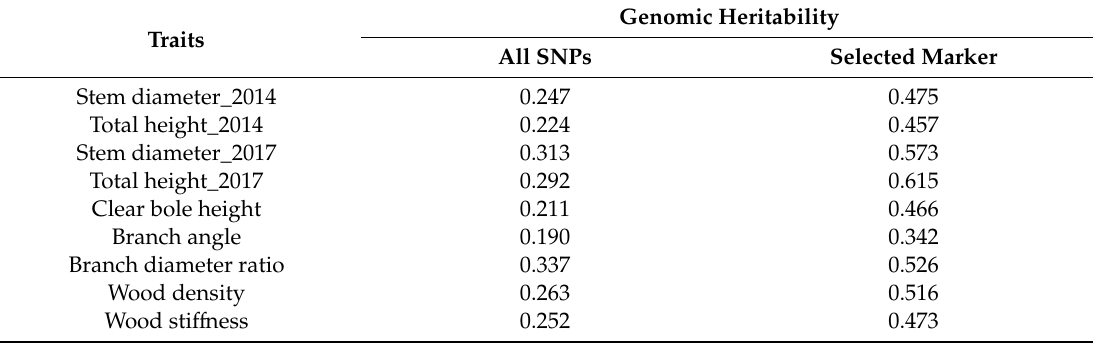
Table 5. Genomic heritability of growth, branch and wood quality traits of S. platyclados